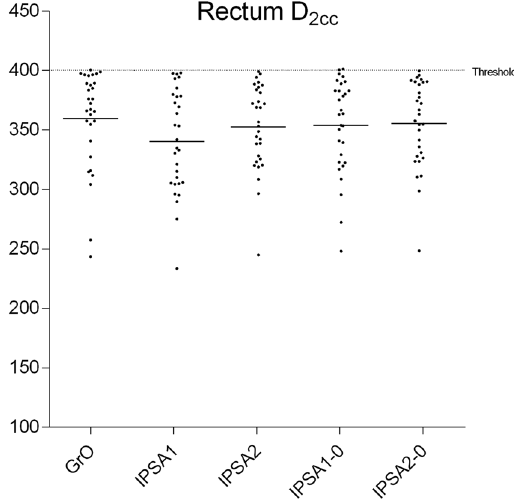
Figure 4. Comparison of rectum D 2cc among different